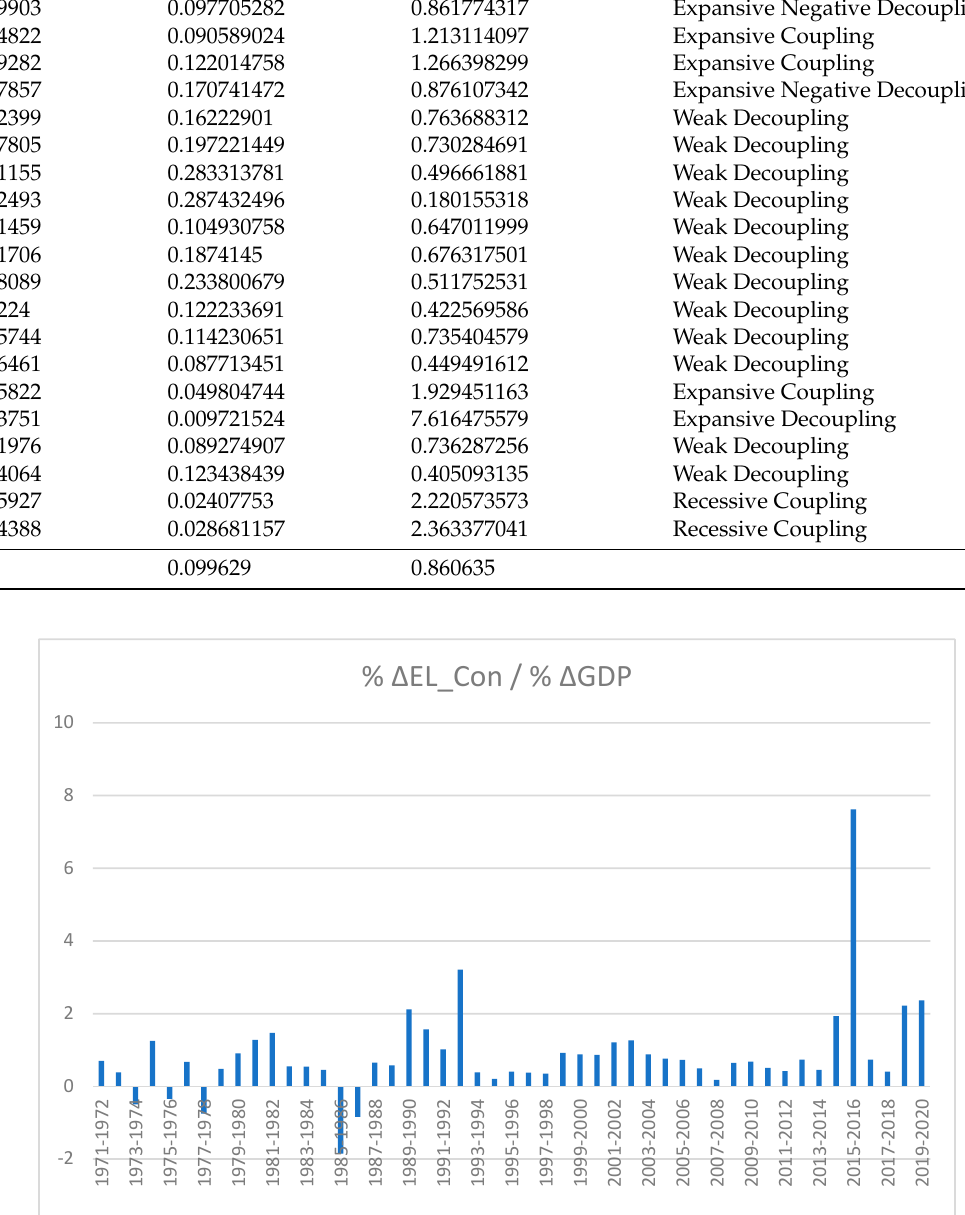
-4 Figure 5. The states of decoupling of electricity consumption total and GDP in China during 1971–2020.